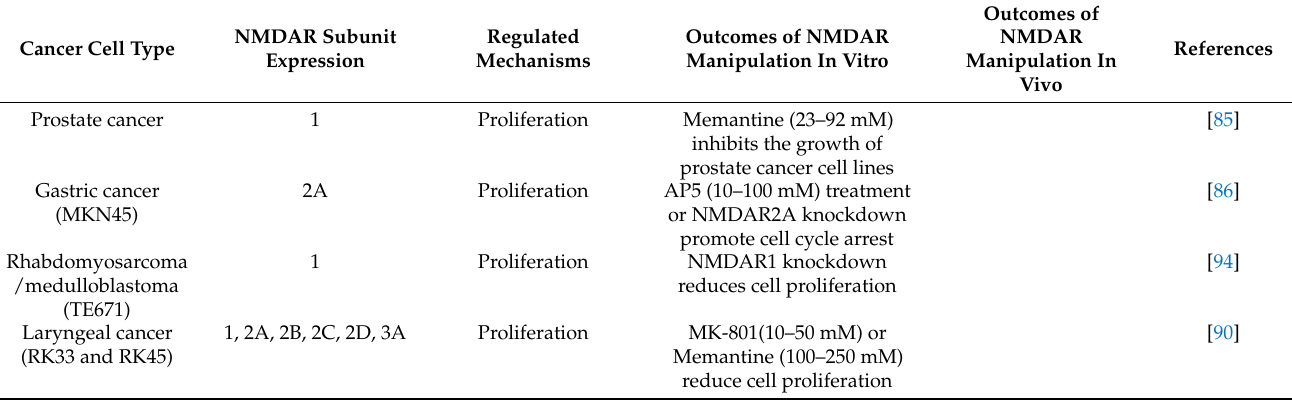
Table 1. NMDA receptor regulation of cancer, cell growth, migration, and